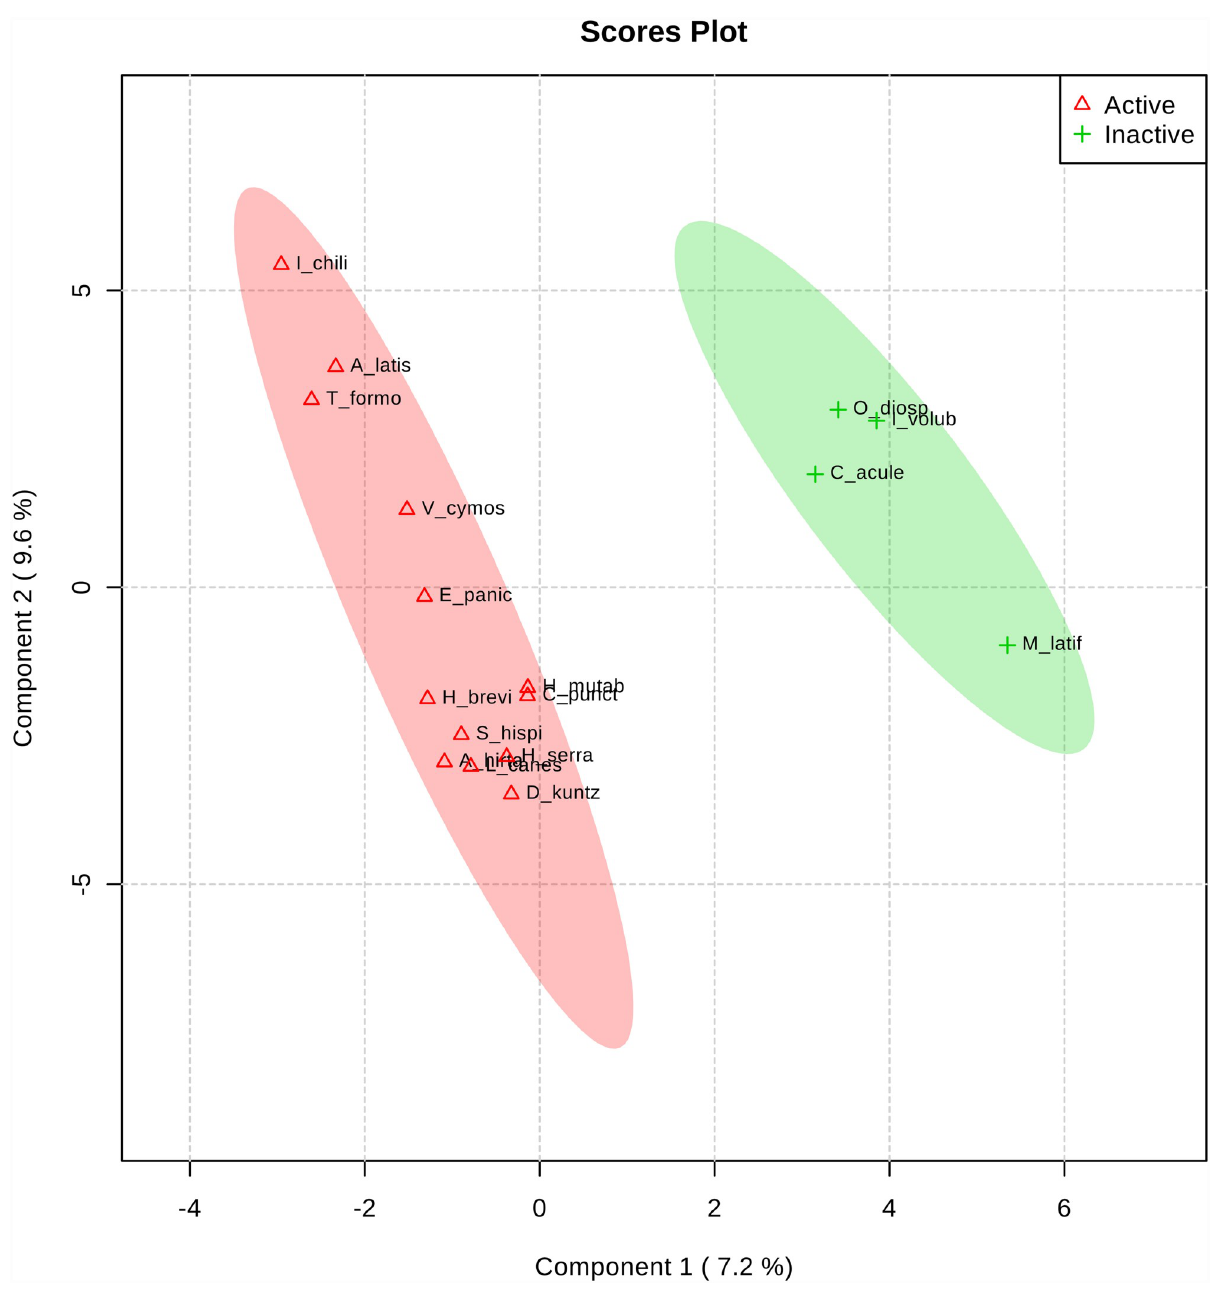
Fig 1. Geometric profile of active (triangle) and inactive (plus sign) fraction. Dispersion graph of PLS-DA points (each point represents ethanol extract of plant species).